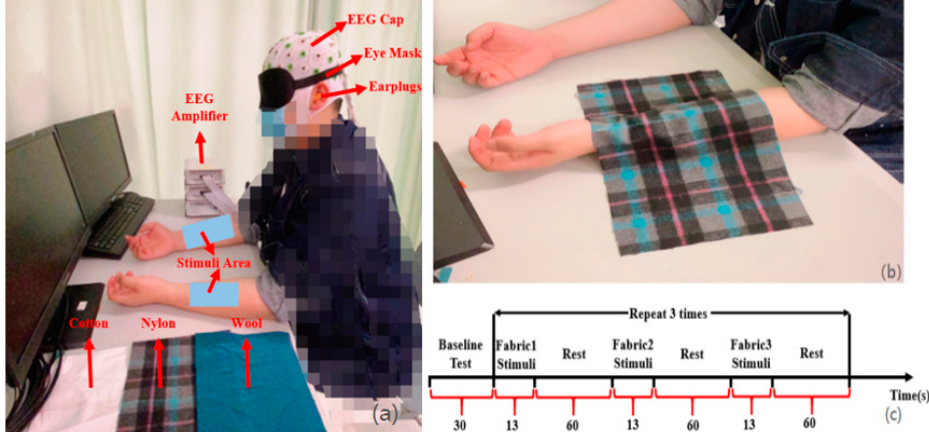
Figure 1. Electroencephalography (EEG) experimental setup and protocol. ( a ) Participant wearing the EEG cap, ear plugs, and eye mask, is seated in a chair and tested with their hands comfortably placed on the table. The areas of each fabric stimulation are the ventral forearms. The three fabric samples, namely cotton, nylon, and wool, are placed on the table. ( b ) Illustration of fabric stimulation. The nylon fabric is placed on the ventral forearm. ( c ) Protocol for fabric stimulation. Table 1. Demographic characteristics and clinical scores of the stroke and control groups [28].